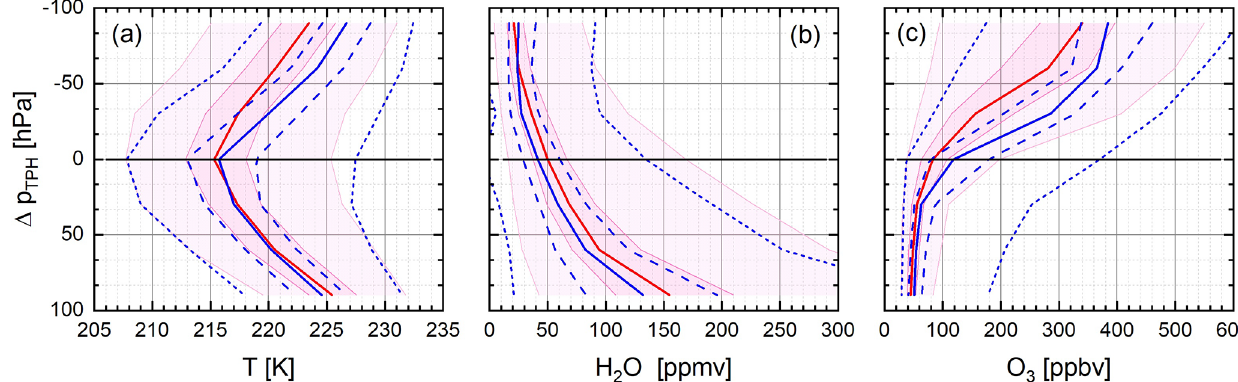
Figure 9. Vertical distribution of temperature T (a) , H 2 O VMR (b) , and O 3 VMR (c) relative to the 2PVU dynamical tropopause and to the thermal tropopause. Vertical distributions relative to the thermal tropopause are presented as percentiles (1, 25, 50, 75 and 99) by blue lines, and those relative to the 2PVU tropopause conditions are represented by red-shaded areas.